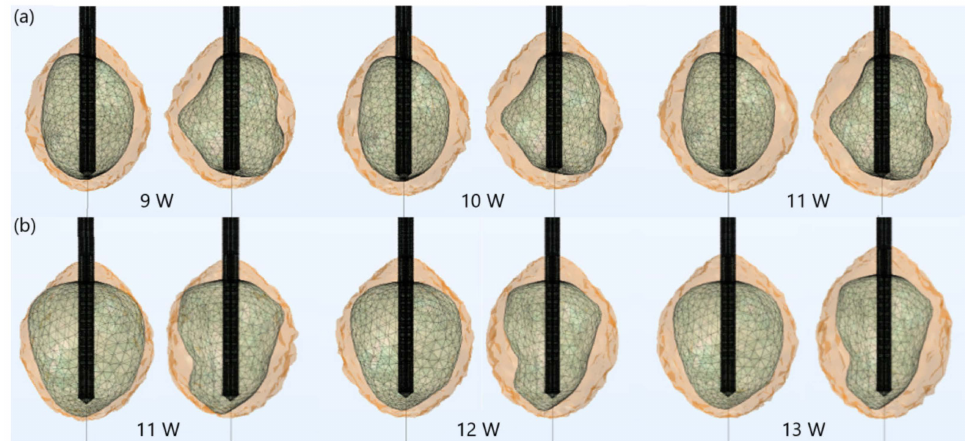
Figure 3. Iso-contours representing the ablated regions (solid light brown surface) after 600 s of MWA at 2.45 GHz around tumors (triangulated surface) ( a ) 1.07 [51] (for input powers of 9 W, 10 W, and 11 W) and ( b ) 1.03 [51] (for input powers of 11 W, 12 W, and 13 W).